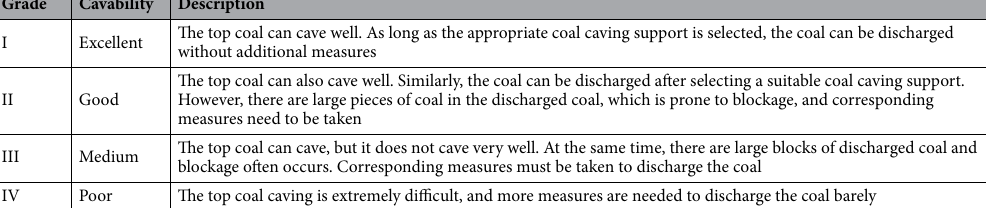
Table 1. Classification of top coal